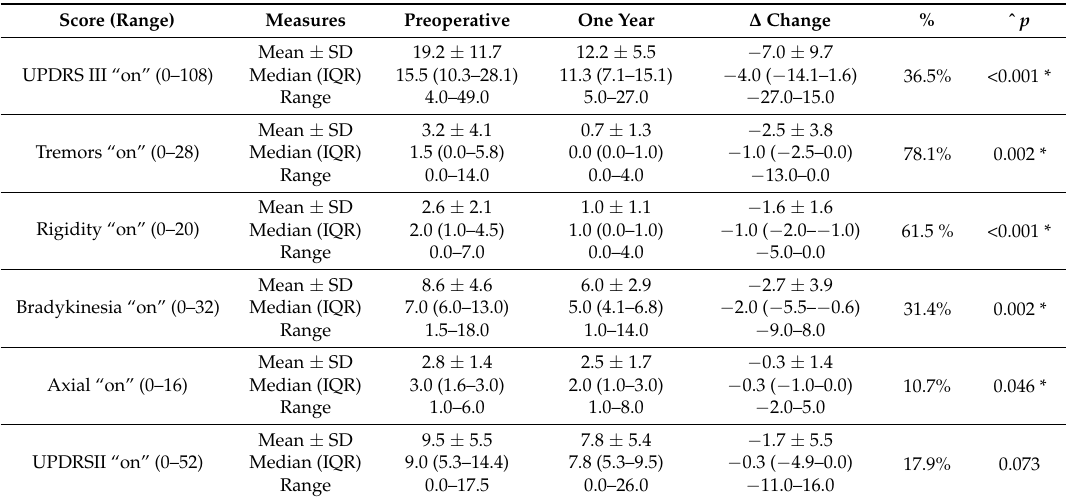
Table 3. Changes in the “on” medications UPDRS III and UPDRS II